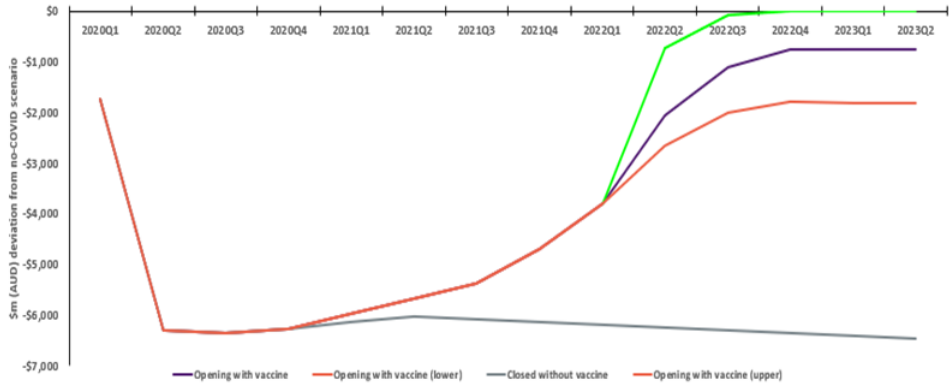
Figure 4. Real tourism exports: Estimated deviation relative to no COVID scenario (%).